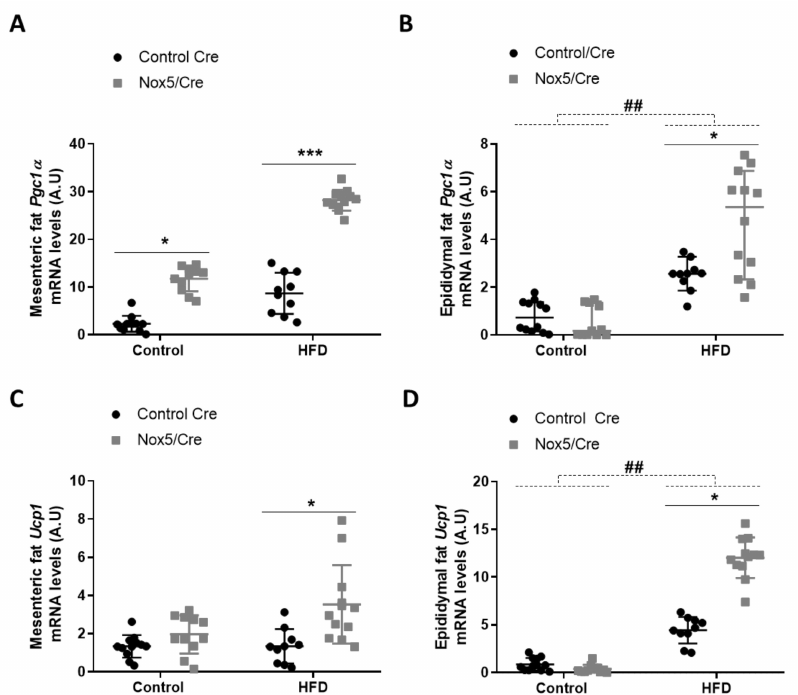
Figure 1. Endothelial NOX5 expression increased Pgc1 α and Ucp1 mRNA levels in mesenteric and epididymal fat in mice fed with a HFD for 10 weeks. Pgc1 α mRNA levels in ( A ) mesenteric fat and ( B ) epididymal fat. Ucp1 mRNA levels in ( C ) mesenteric fat and ( D ) epididymal fat. Control diet: control Cre ( n = 12), Nox5/Cre ( n = 11); HFD: control Cre ( n = 10), Nox5/Cre ( n = 12). Results are expressed as mean ± SEM. mRNA levels are relative to Gapdh . ## p < 0.01: diet differences (dotted lines); * p < 0.05, *** p < 0.001: genotype differences (solid lines). Statistical test used: two- way